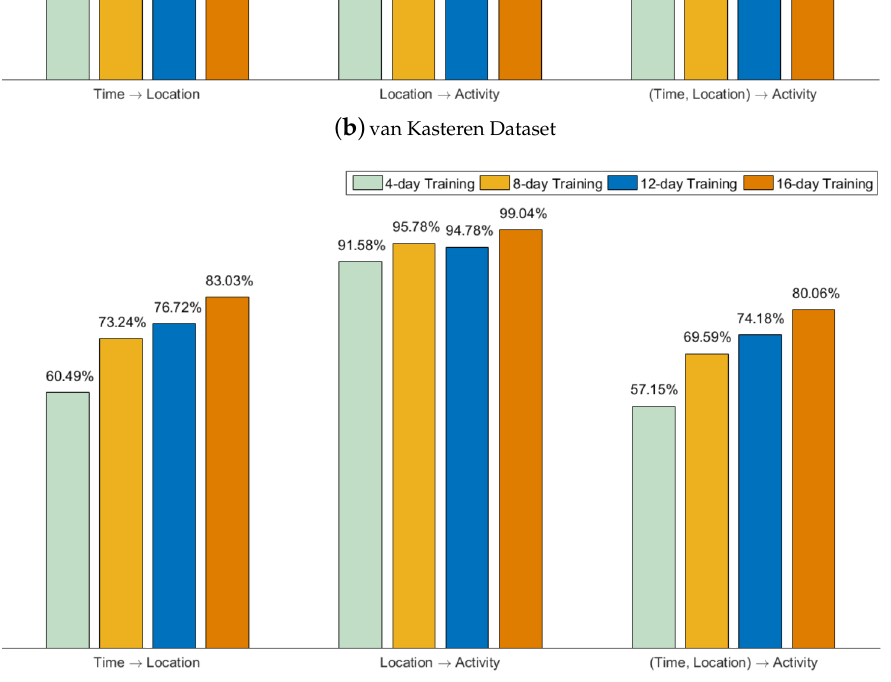
Figure 4. Recognition performance on different training-test